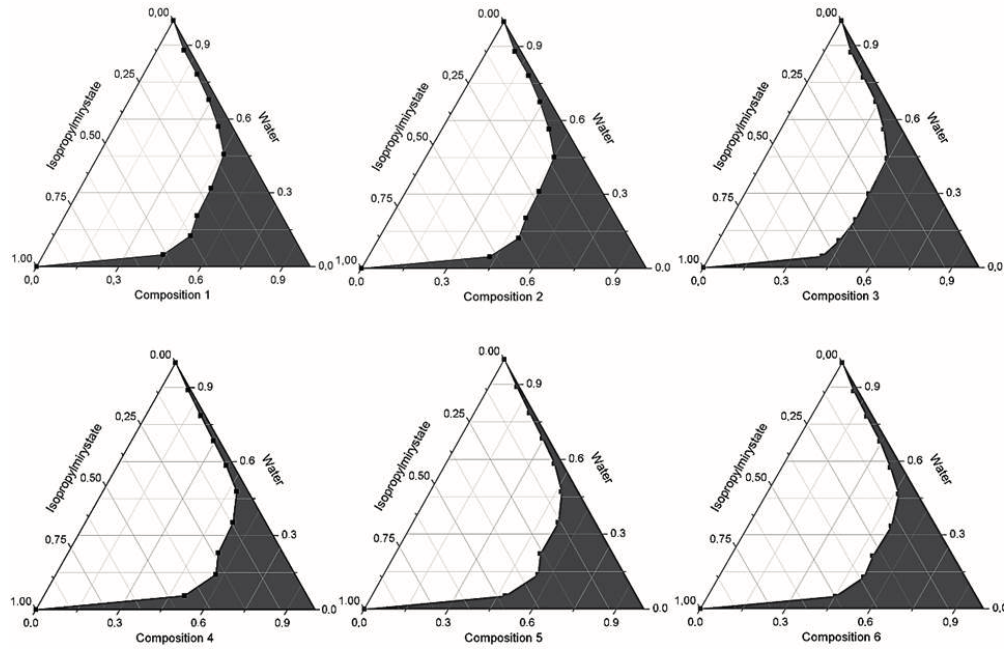
Figure 1. Pseudoternary phase diagrams of compositions 1–6, (Shaded areas represented microemulsions).